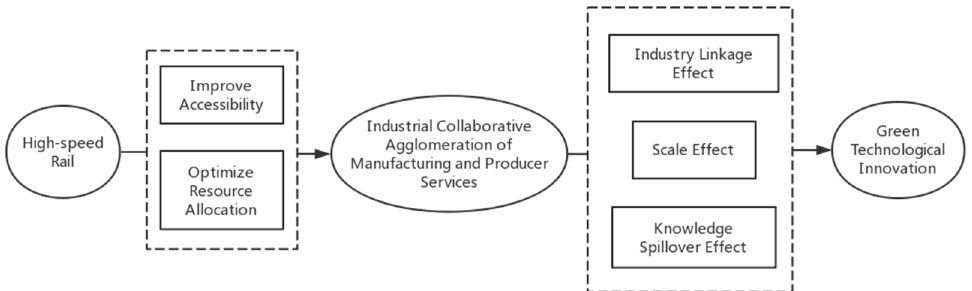
Figure 1. Mechanism diagram of high-speed rail, industrial collaborative agglomeration, and green technology innovation.